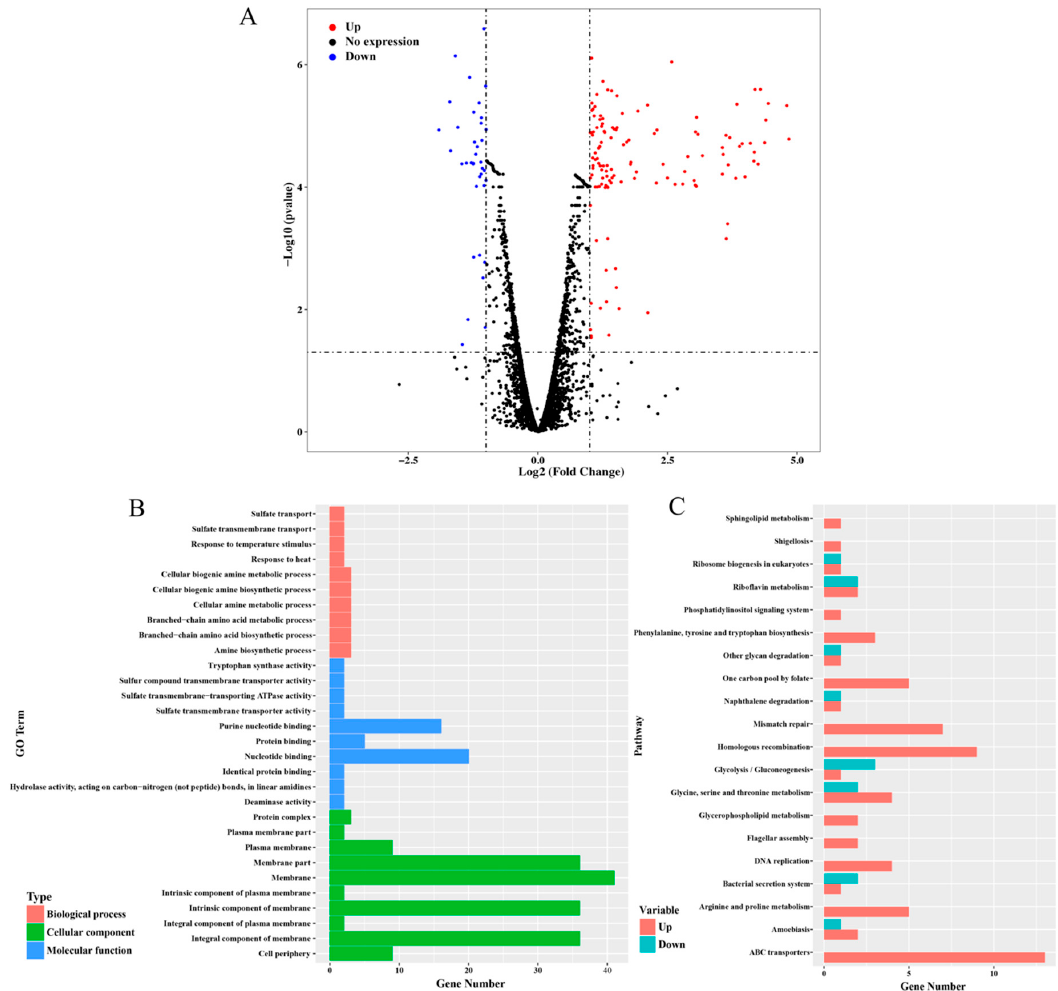
Figure 3. RNA-seq analysis between WT and ∆ Dsr11 . ( A ) Volcano map of the differential expression genes ∆ Dsr11 versus WT. Each point represents a unigene. The red and blue points indicate significant changes in the absolute value of log 2 (fold change) ≥ 1 and FDR ≤ 0.05, respectively; i.e., the red points indicate up-regulated unigenes, and the blue points indicate down-regulated unigenes in the two groups, with the differential expression levels presented along the X -axis. The black points indicate nonsignificant, differentially expressed unigenes ( B ) GO terms with significant enrichment analysis of differentially expressed genes in ∆ Dsr11 compared to WT. ( C ) Top 20 KEGG biological pathway classification histograms for annotated unigenes.